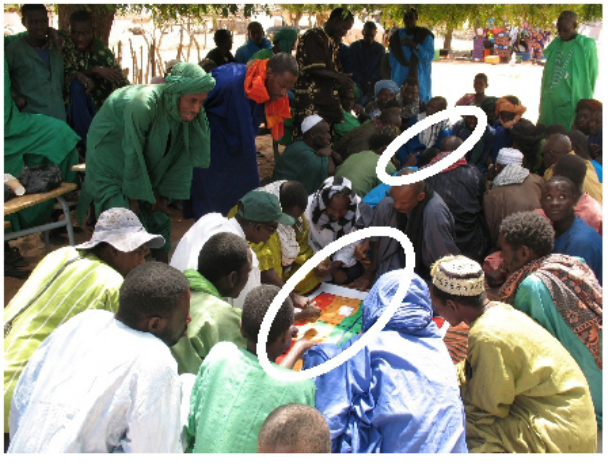
Fig. 6 . A game session with different board maps, allowing many participants to be